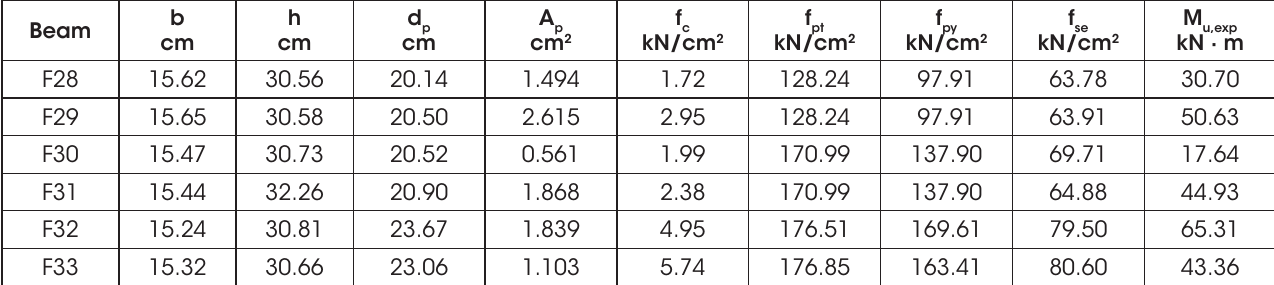
Table 5: Data of the beams tested by TAO e DU [11]